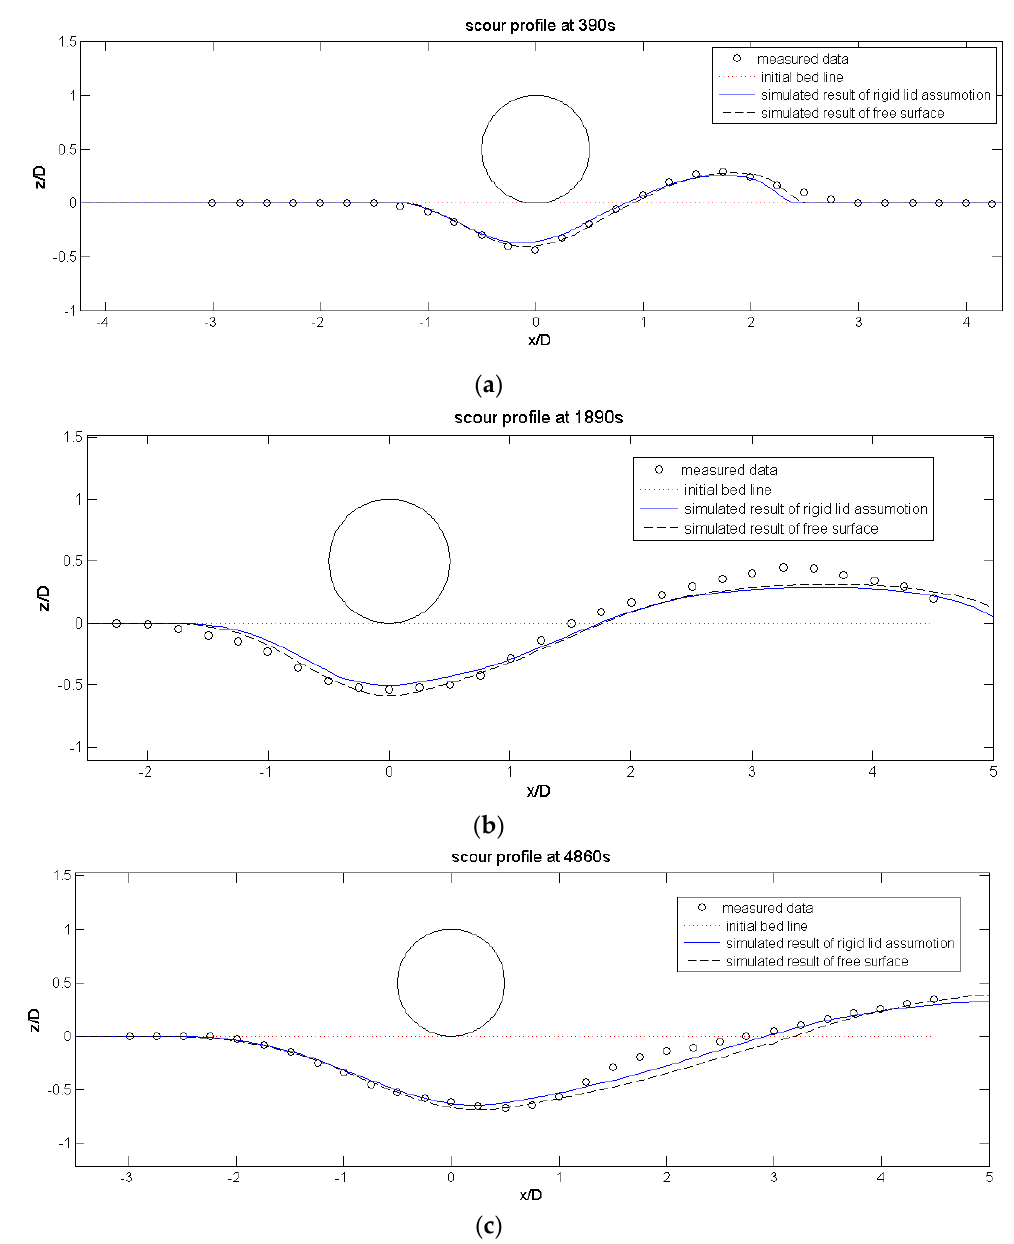
Figure 16. The scour profile of the free surface model and rigid lid assumption at different times in the case of Fr = 0.214, ( a ) T = 390 s; ( b ) T = 1890 s; ( c ) T = 4860 s.